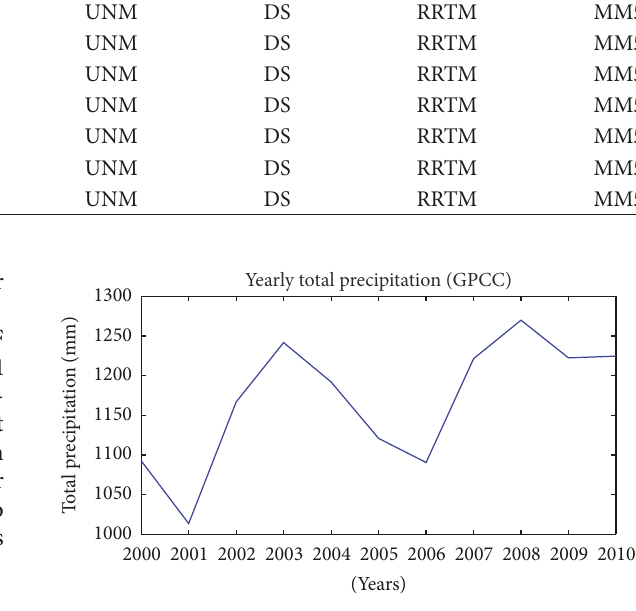
Table 2: Seven different WRF parameterizations scheme combinations or configurations (Confs) used for the simulations. Conf.